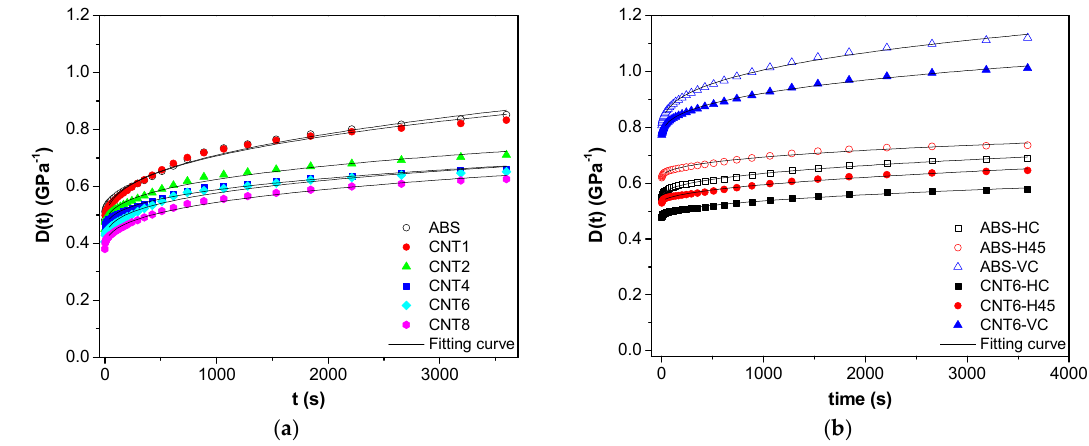
Figure 9. Creep compliance, D(t) at 30 °C, of neat ABS and nanocomposites as measured on ( a ) filaments at 3.9 MPa and ( b ) 3D-printed samples along different orientations at 3.0 MPa. Table 7. Elastic ( D el ), viscoelastic D ve ( t = 3600 s) and total D ( t = 3600 s) creep compliance at 3600 s and fitting parameters (Equation (11)) of ABS and its nanocomposites as measured on filaments and FDM samples.